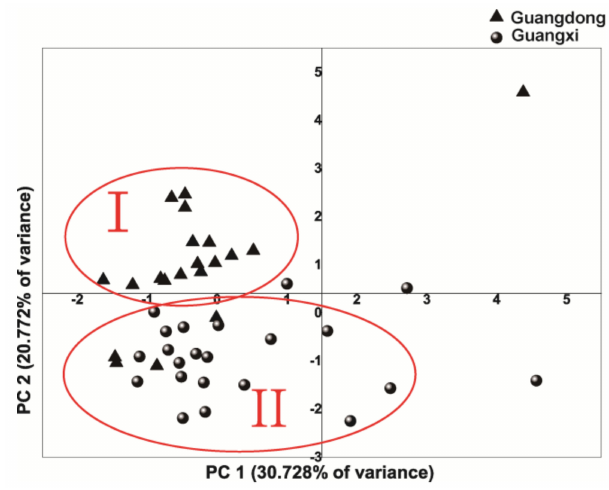
Figure 3. Score plot of principal analysis (PC1-PC2) of 42 bark samples of